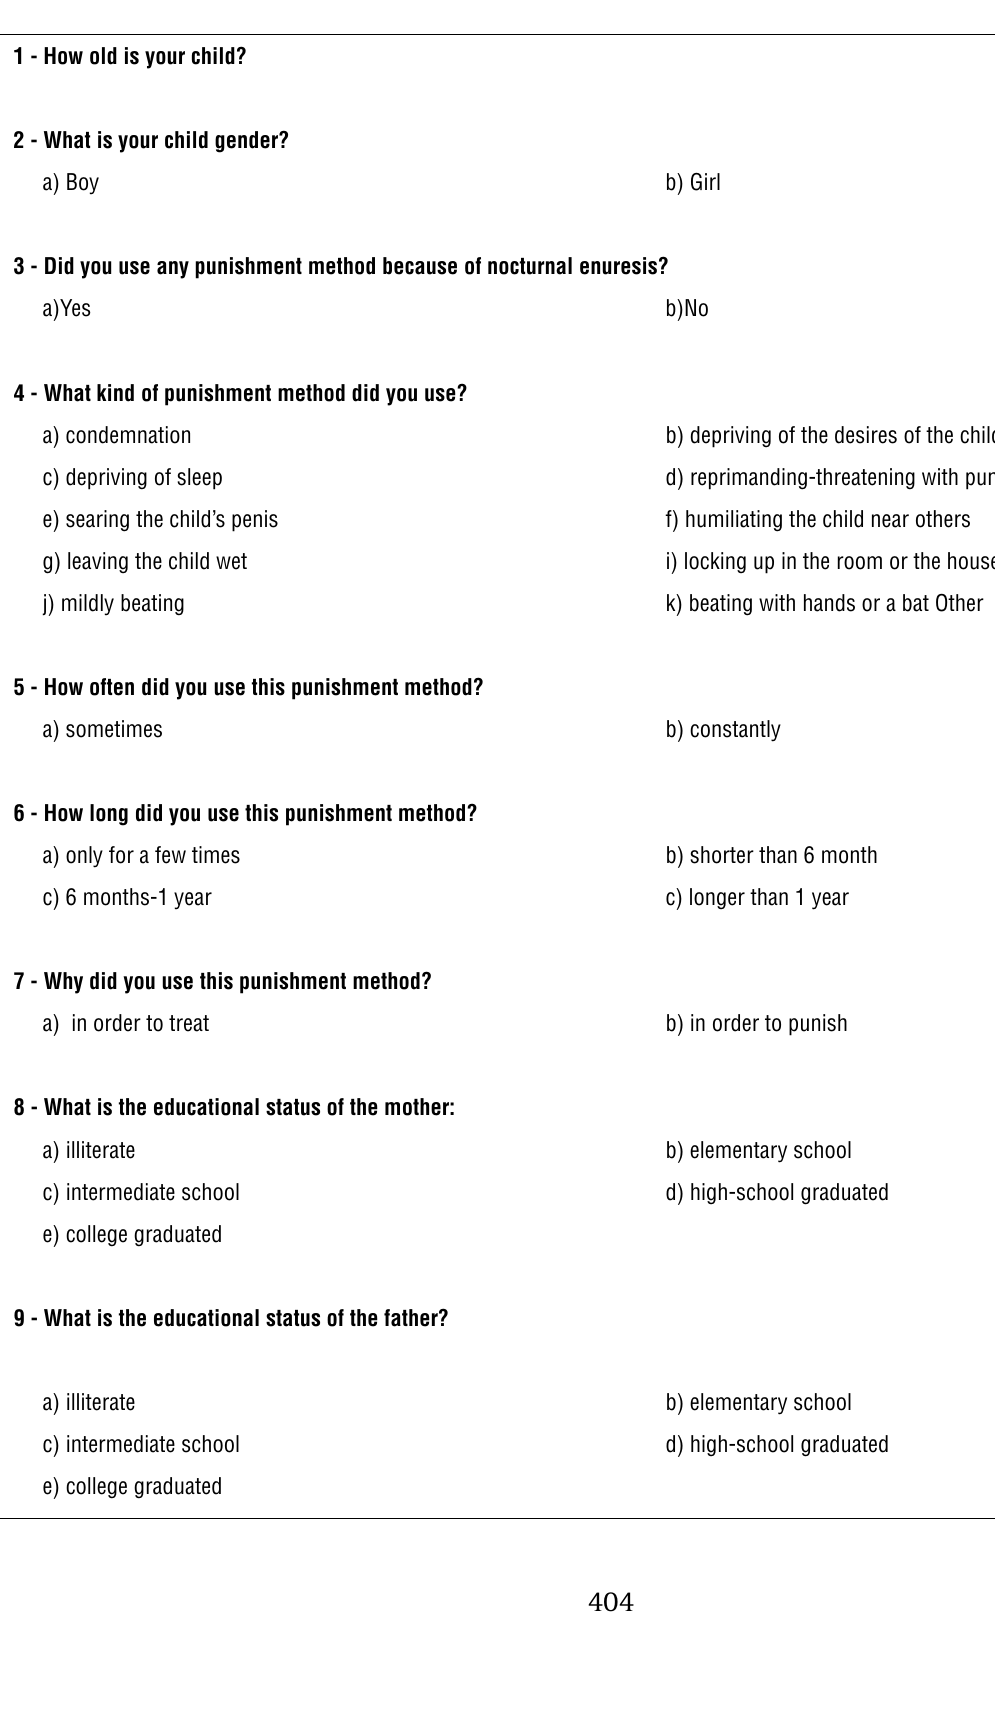
Table 1 - Questionnaire for nocturnal